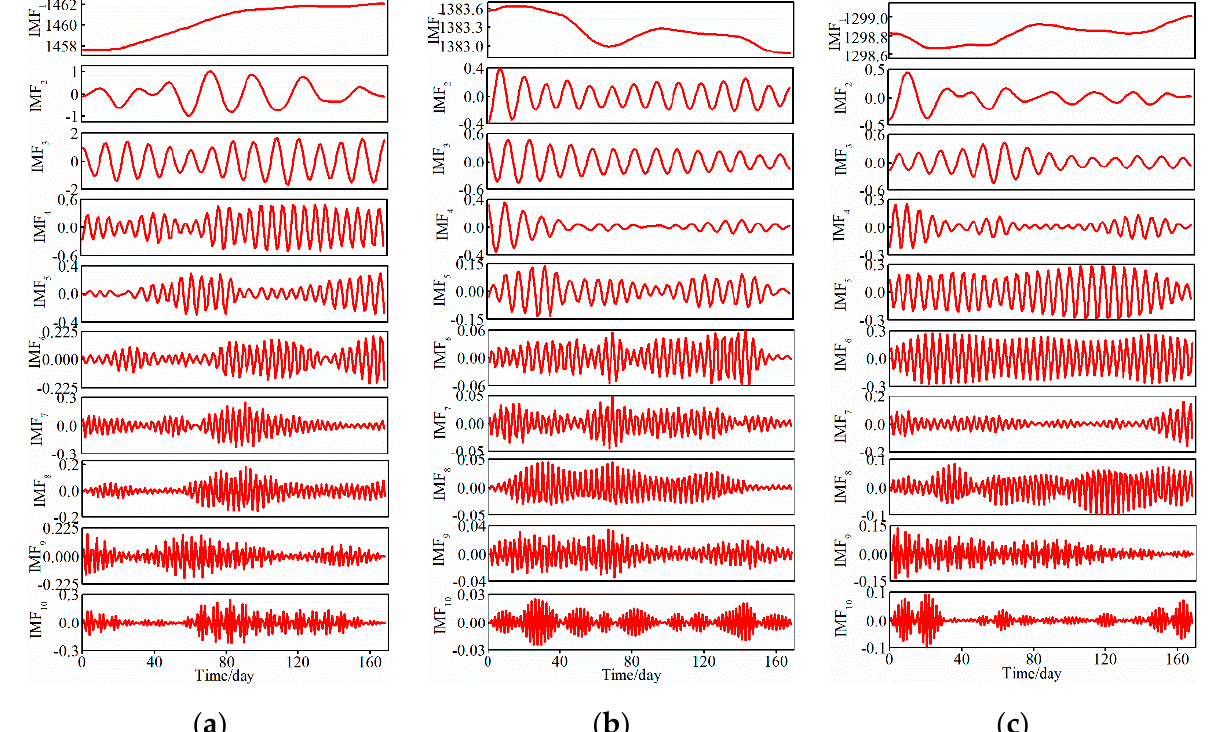
Figure 3. Decomposed results of training periods by variational mode decomposition (VMD) for monthly groundwater level at Well I ( a ), Well II ( b ) and Well III ( c ).